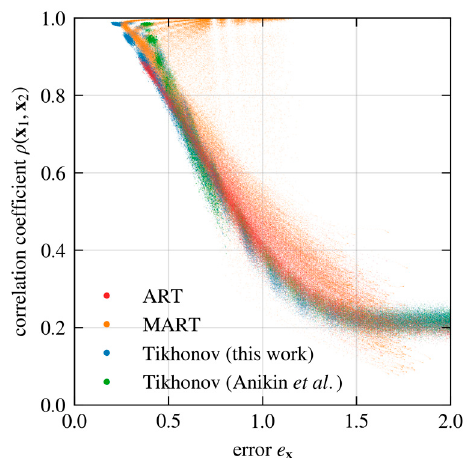
Figure 7. Strong correlation between the reconstruction error e x and the correlation coe ffi cient ρ ( x 1 , x 2 ) obtained from two reconstructions of the same true distribution but with independent noise.